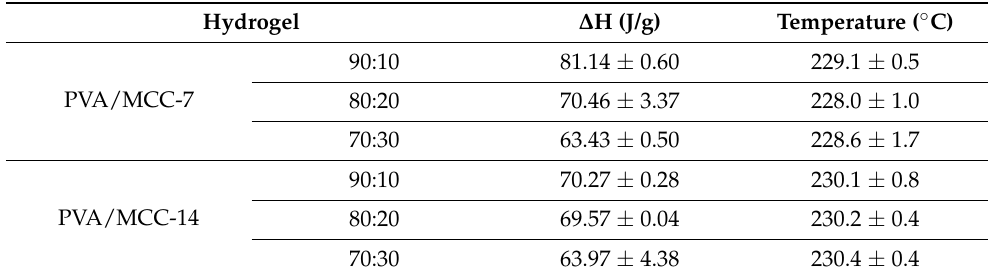
Figure 5. Thermograms of PVA/MCC-7 ( A ) and PVA/MCC-14 ( B ) hydrogels with (a) 90:10, (b) 80:20, and (c) 70:30 ratios. Table 5. Enthalpy of fusion ( ∆ H) and temperature peak obtained by differential scanning calorimetry (mean ± SE; n = 3).